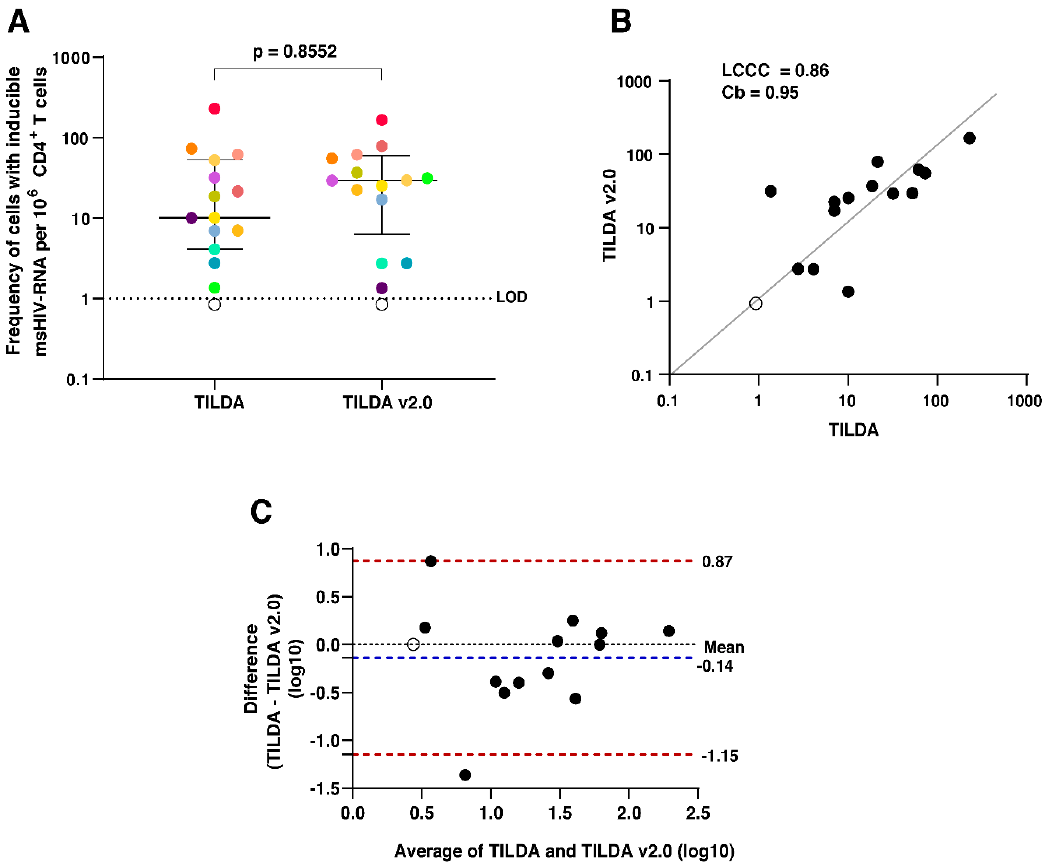
Figure 2. TILDA inter-laboratory reproducibility. ( A ) The frequency of CD4+ T cells expressing tat/rev msRNA after in vitro stimulation with PMA/Ionomycin on a subset of individuals ( N = 15) quantified by TILDA and TILDA v2.0. Each individual is represented by a different colored dot. The open circles are below the LOD. Wilcoxon’s matched-pairs test was used to compare the medians. Statistical significance is determined by p < 0.05. ( B ) Lin’s Concordance Correlation Coefficient (LCCC) plot. The black dots represent inducible reservoir size quantified by TILDA and TILDA v2.0. The open circle is below the LOD. The grey diagonal line represents the best-fit line. Coefficient of bias (Cb) is a measure of accuracy. ( C ) Bland–Altman plot using log-transformed inducible reservoir size measurements by the two assays. The open circle is below the LOD. The blue dotted line represents the mean bias, and the red dotted lines represent the 95% limits of